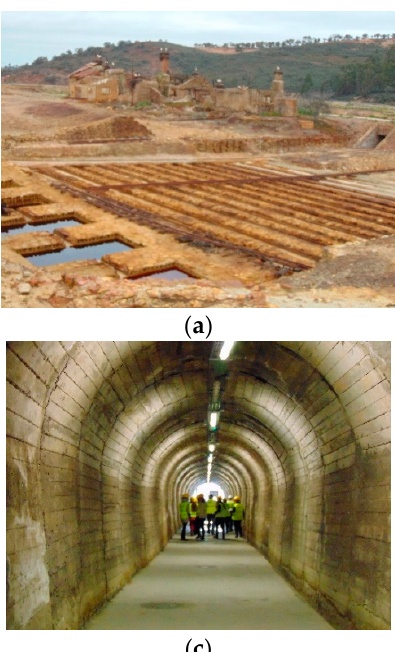
( f ) Figure 2. Remediation measures executed by EDM in the old part of the Aljustrel mine: ( a ) overall view; ( b ) confined materials deposited in Algares; ( c ) area covered with clean soil and revegetated with a mixture of herbaceous plants; ( d ) perimetral channels to collect the acid drainage waters; ( e ) evaporation-concentration ponds receiving the drained waters;